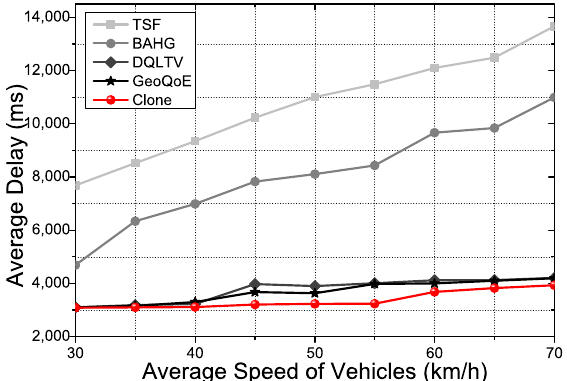
Figure 8. Average delay for average speed of vehicles.